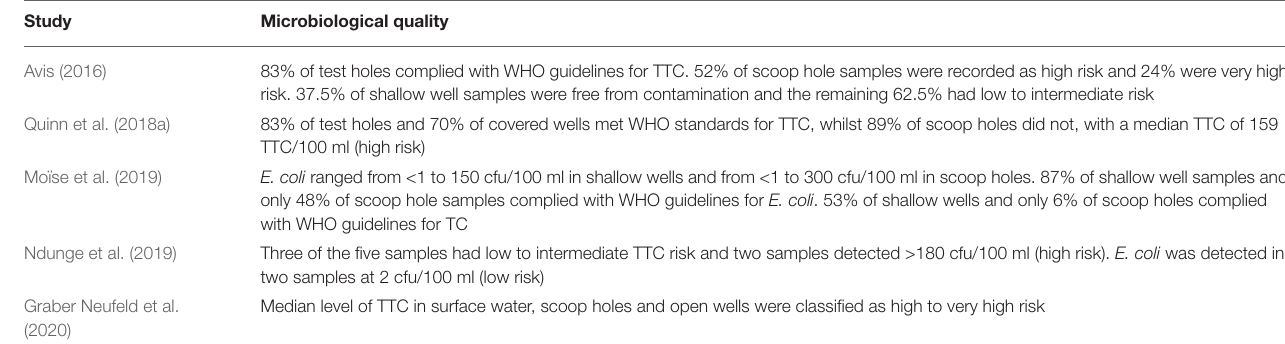
TABLE 5 | Measures of microbiological quality in different studies.